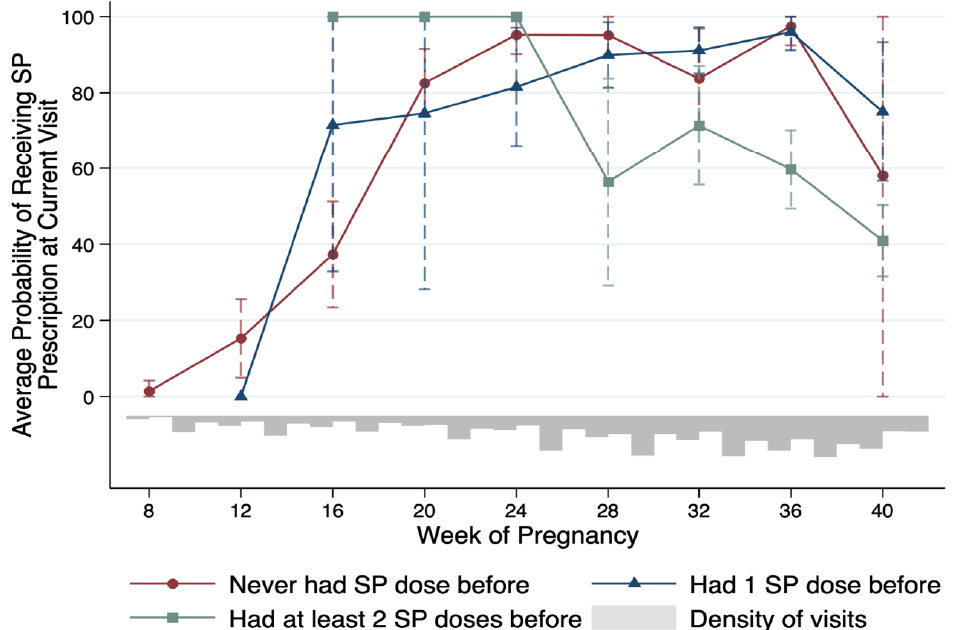
Figure 1. Mean Probability of Receiving IPTp Prescription at ANC Visits, by IPTp History. Note: The x-axis is the gestational age measured by month approximated by every 4-week interval. ANC visits in corresponding categories of IPTp history (color-coded) are collapsed at the same time interval to compute the mean probabilities (y-axis) and corresponding 95% confidence intervals. The bottom gray histogram plots the distribution density of the unconditional ANC visits along the week of pregnancy.